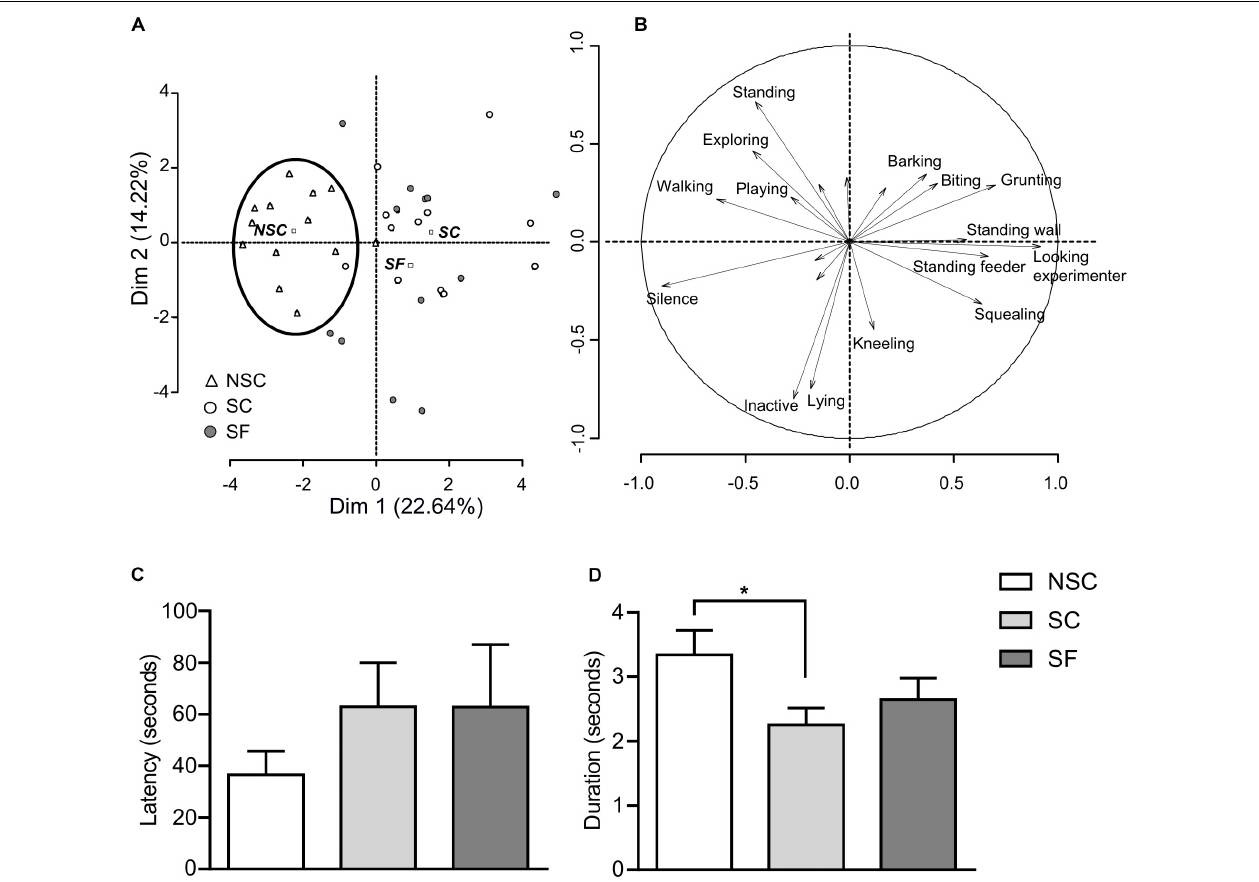
FIGURE 2 | Behavioral assessments. The principal component analysis (PCA) of behaviors expressed by 12 pigs/group in home pens ( A , animals projections; B , behaviors projections) showed that non-stressed (NSC) animals constituted a cluster characterized by the expression of behaviors such as “playing” and “exploring,” while emitting very few vocalizations. Stressed animals treated (SF) or not (SC) with the anti-depressant fluoxetine did not differ and expressed behaviors such as “standing in the feeder,” “looking at the experimenter,” while emitting low- and high-pitched vocalizations. Novelty-suppressed feeding (NSF) test did not show differences in the latency to eat; nevertheless, there was a higher variability in stressed groups (C) . N = 11–12/group. In restraint test SC had a lower perseverance index than NSC ( p = 0.019), and SF did not significantly differ from the other groups (D) . N = 9–11/group, mean ± SEM, two-way ANOVA, ∗ p <